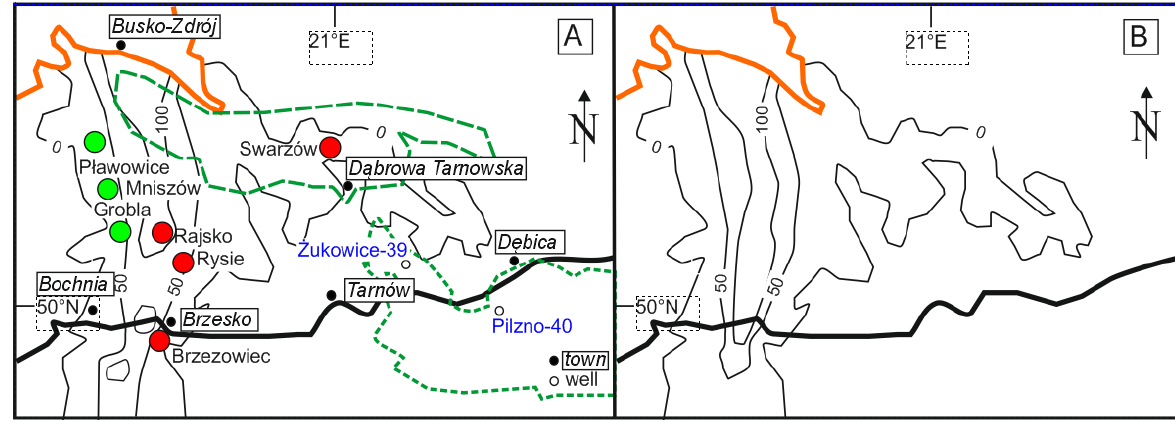
Figure 11. Simplified maps of: ( A ) distribution of oil (green dots) and gas (red dots) fields in reservoirs of Cenomanian sandstones [4], on the thickness (in m) of Cenomanian strata [35]. Dark green lines show the pattern of the Ordovician– Silurian source rocks [40]. ( B ) Hydraulic conductivity (in m 3 /s × 10 − 5 ) in Cenomanian sandstones [35]. The orange line shows the northern extent of the Miocene sediments. The bold black line shows the northern occurrence of the Outer Carpathians. Note that the southern extent of Cenomanian sandstones is under the Outer Carpathians. Hydraulic conductivity values increase with the thickness of Cenomanian sandstones.